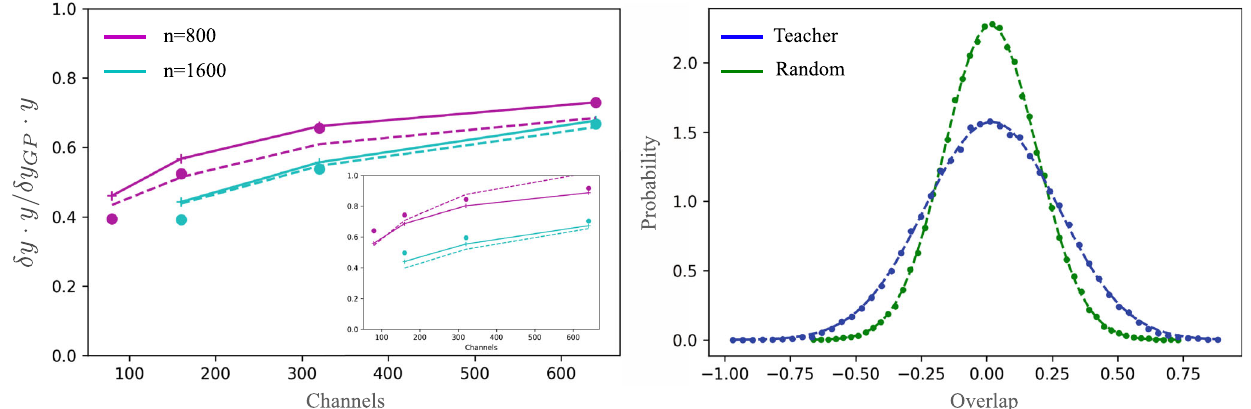
Fig.3|Theoryandexperimentcomparisonforthe2-layernon-linearCNN. Left. Discrepancy measured along target direction normalized by that of the corre- sponding GP ( α / α C → ∞ ). Dots denote empirical values for the test-set. Dashed and solid lines are theoretical predictions via an approximate-analytical and exact-